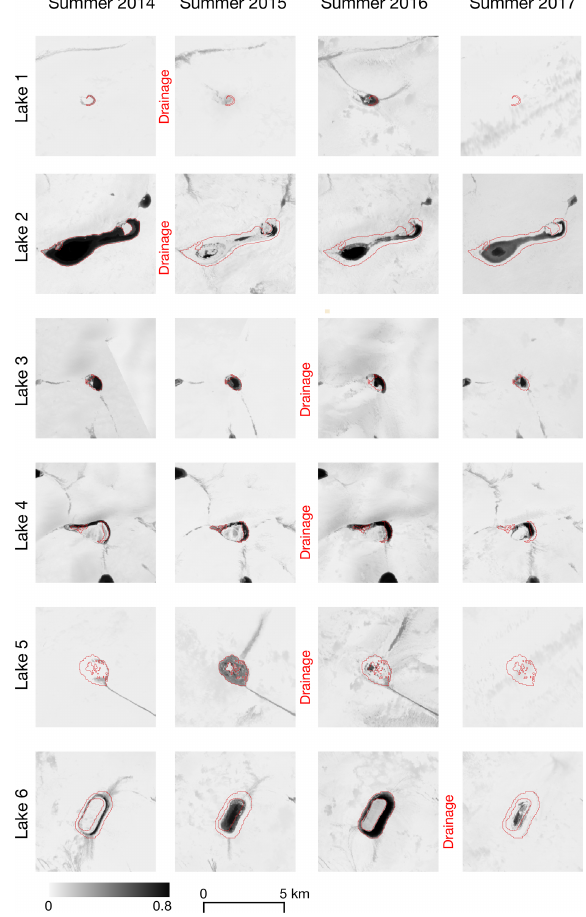
Figure 6. NDWI ice for each identified drained lake at the peak of each summer within the study. Note that most lakes take more than a single summer season to recover from their winter